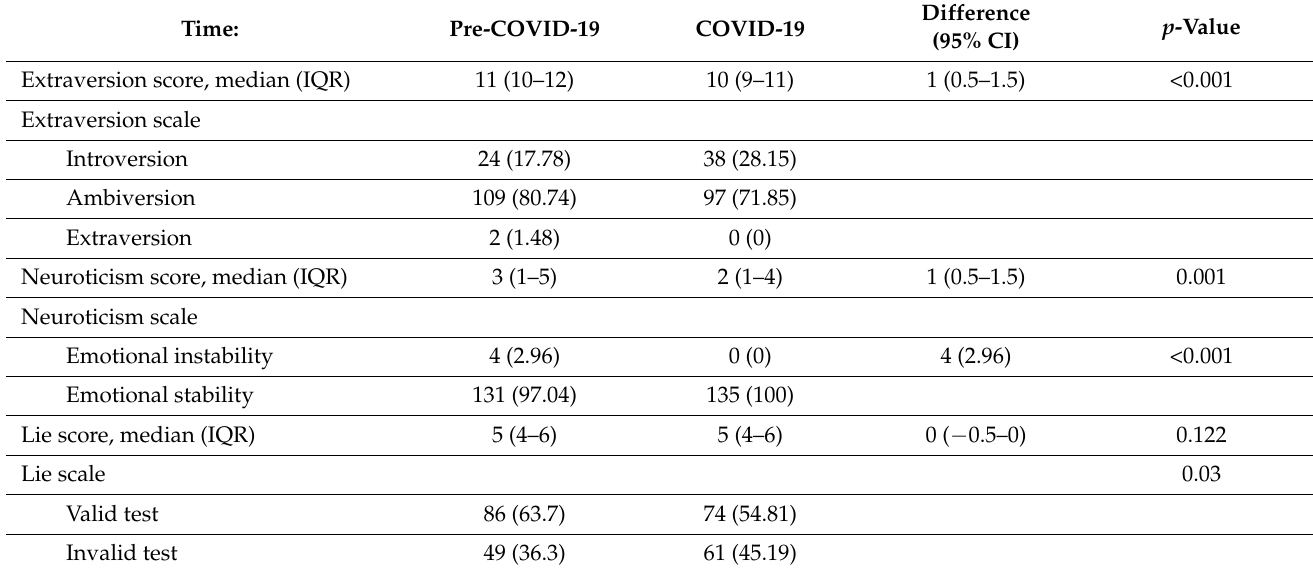
Table 3. Comparison of Eysenck Personality Inventory in the pre-COVID-19 versus the COVID-19